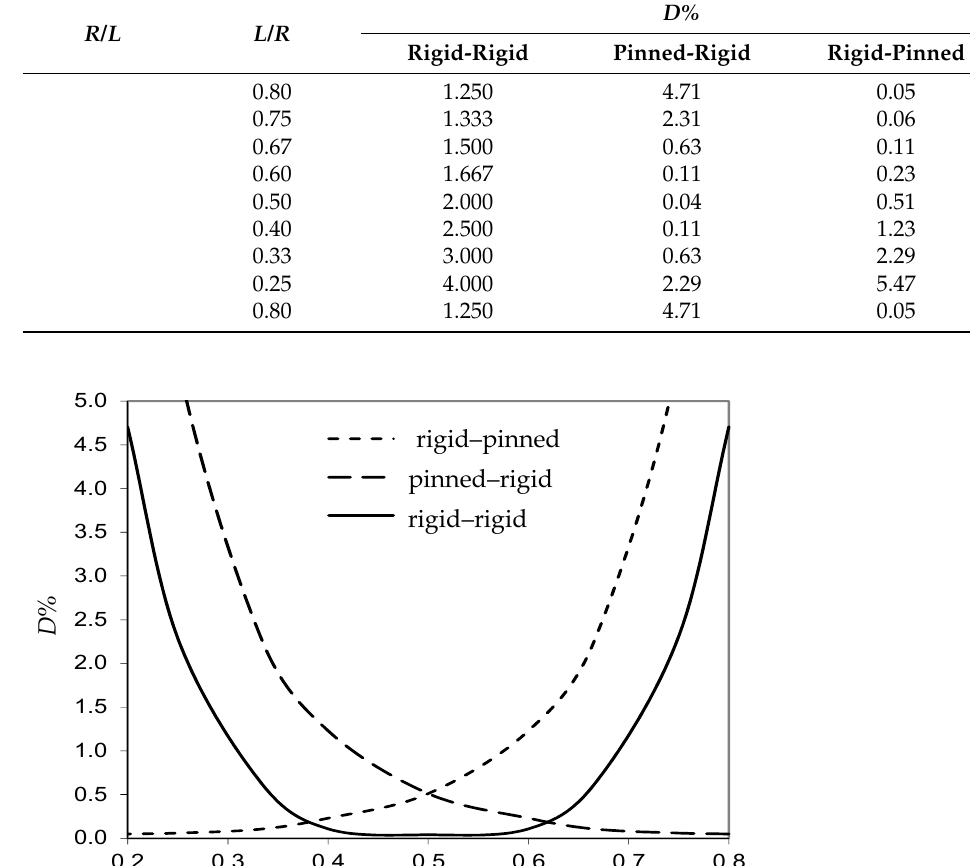
Table 2. Maximum deviation of ω 2 / ω 02 from linear dependence in the range of 0 ≤ u ≤ u cr for various L / R ratios.